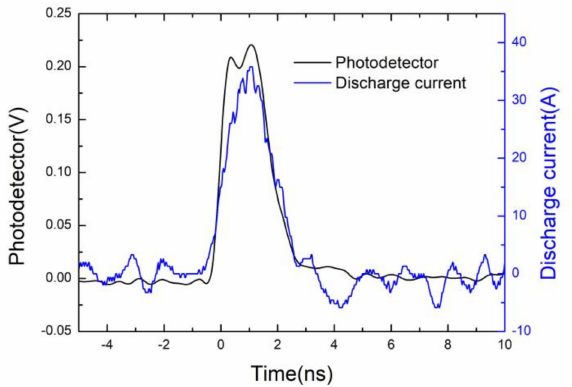
Figure 10. The comparison between the discharge current waveform obtained by differentiation and the laser pulse waveform detected by the photodetector.